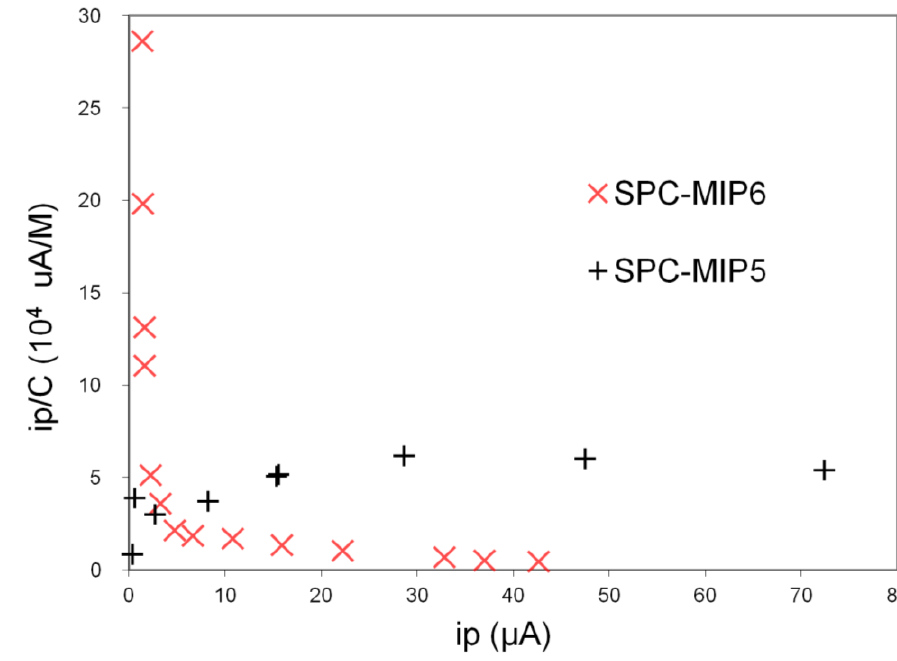
Figure 5. Scatchard plots for binding of 2-FAL by SPC-MIP6 and SPC-MIP5 sensors based on SWV at